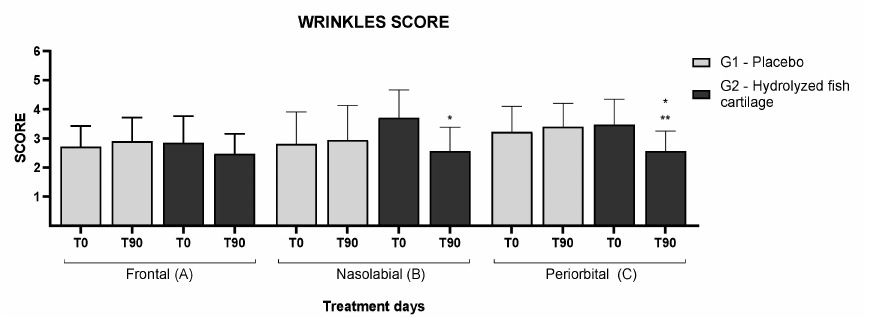
Figure 4. Wrinkle score in the frontal ( A ), nasolabial ( B ), and periorbital ( C ) regions of the face of the participants before (T0) and after 90 days (T90) of supplementation with hydrolyzed fish cartilage or the placebo. Triplicate images of each participant were analyzed using the Visioface ® Quick software version 1.0.3.4. * Significant differences when compared to baseline values—T0 ( p < 0.05). ** Significant differences when compared to the placebo